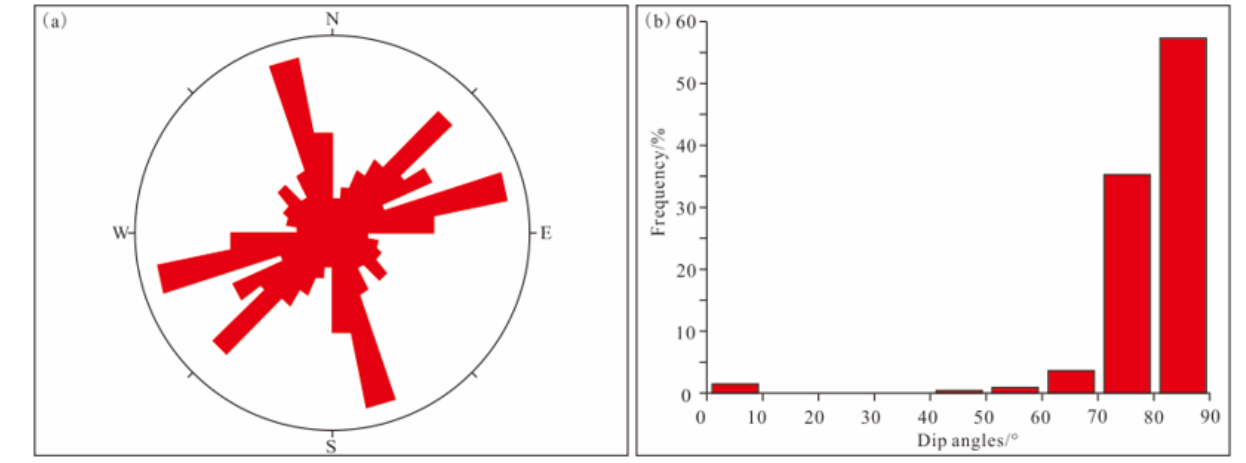
Figure 4. ( a ) Rose diagram of fracture strikes; ( b ) histogram of dip angles in outcrops. Most fractures are filled by different minerals (calcite, quartz, and bitumen); specifi- cally, fully-filled, half-filled and unfilled fractures account for 59%, 16%, and 25%, respec- tively. The half-filled and unfilled fractures are effective ones, while the fully-filled fractures have weak surfaces that are conducive to